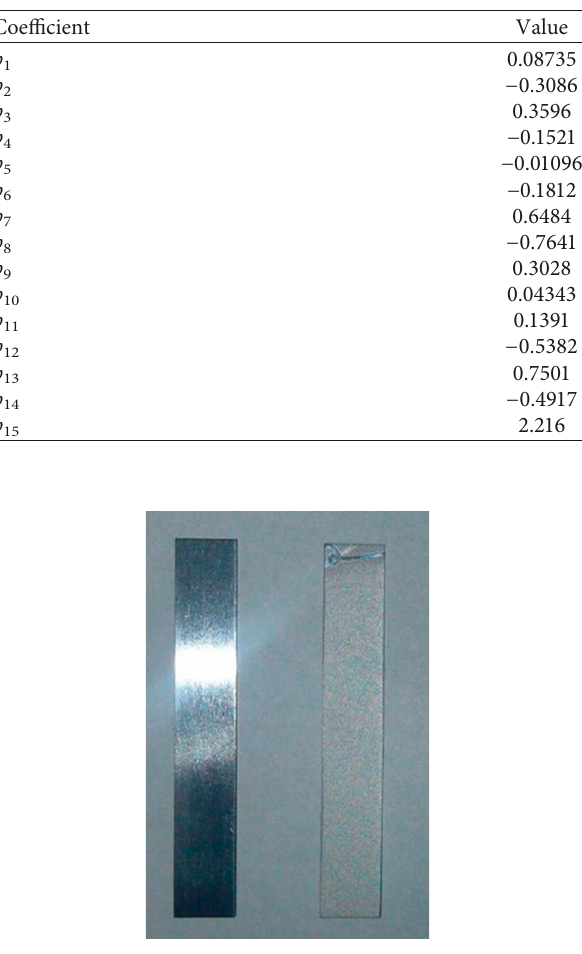
Figure 9: The bare and coated stainless-steel beam.